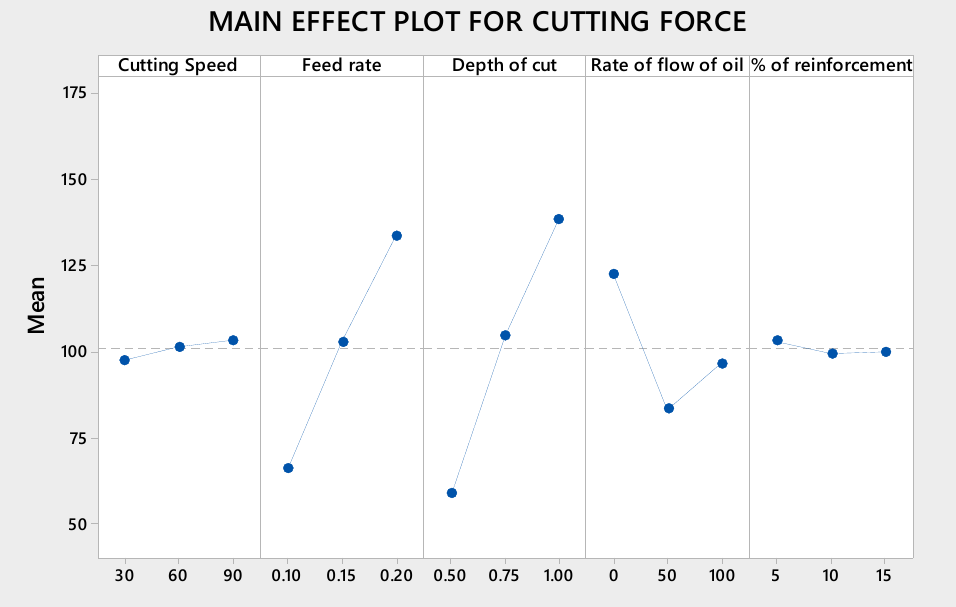
Figure 8. Main effect plot for cutting force.